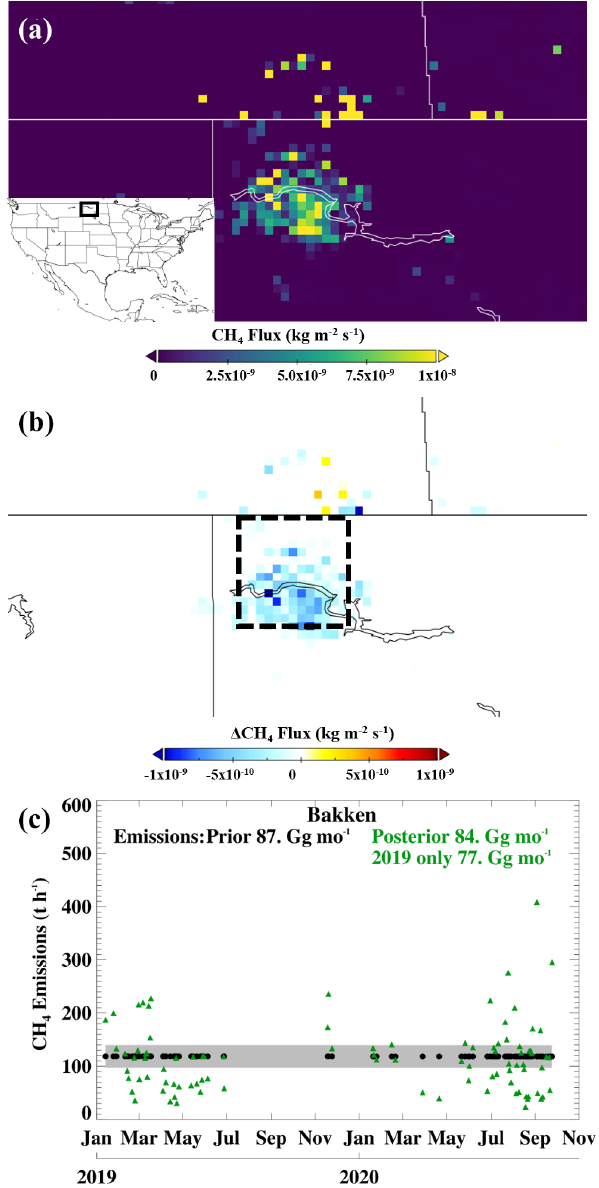
Figure 4. (a) Average prior Bakken CH 4 emissions for 2019. (b) Average of posterior minus prior anthropogenic CH 4 emissions over Bakken for January–June 2019, excluding days for which ob- servations were not available. (c) Time series of total prior (black circles) and posterior (green triangles) anthropogenic CH 4 emis- sion estimates within the 1 ◦ × 1 ◦ Bakken domain, centred around 48.5 ◦ N, 103 ◦ W (black box in b ) for 2019–2020, excluding days for which observations were not available. The shaded error denotes prior